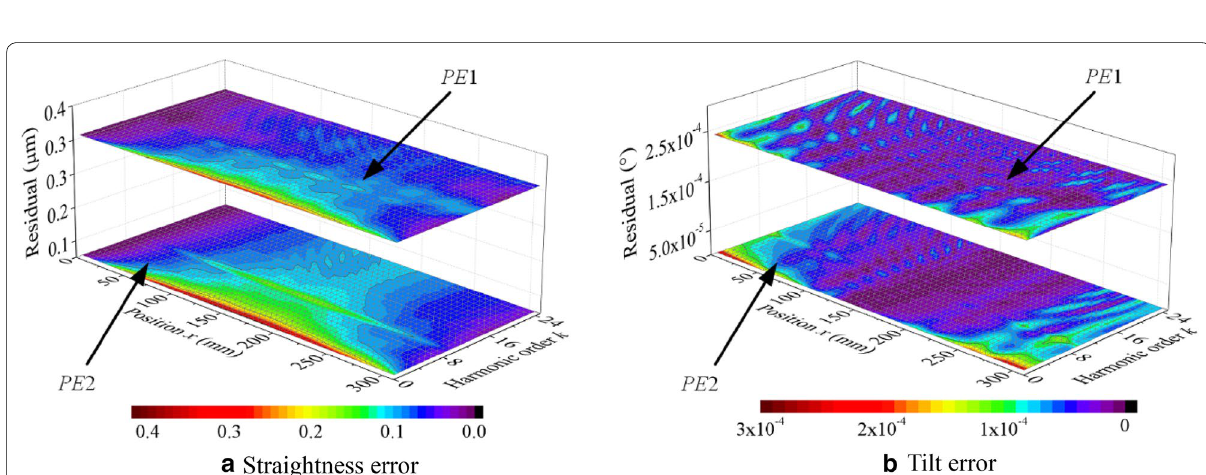
0.2 μm) at the sampling points with the harmonic order k =